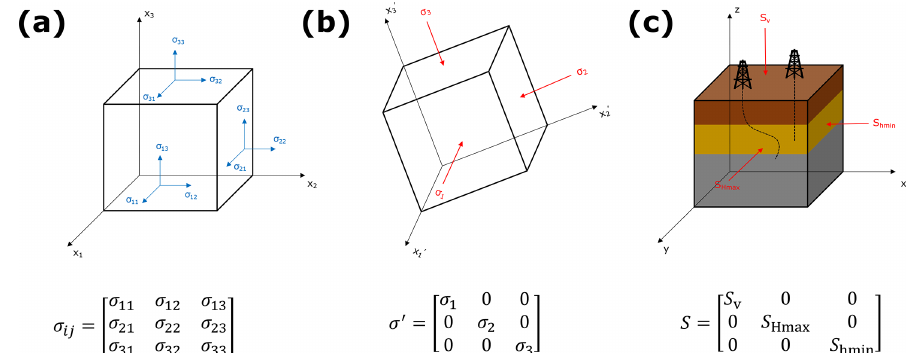
Figure 2. The nine stress tensor components define the stress state at any point and enable the determination of a stress vector on any surface within a given body (a) . Based on the momentum conservation, a stress tensor has to be symmetric, which means that a coordinate system exists where shear stresses are negligible along the cube faces (b) . In this so-called principal axis system, remaining stresses are called principal stresses. With an assumption that vertical stress, S v , is a principal stress, which is a common assumption within the Earth crust, minimum, S hmin , and maximum, S Hmax , horizontal stresses are also considered to be principal stresses (c) . As a result, the so-called reduced stress tensor can be fully determined with only four components including S Hmax orientation and magnitudes of S hmin , S Hmax , and S v